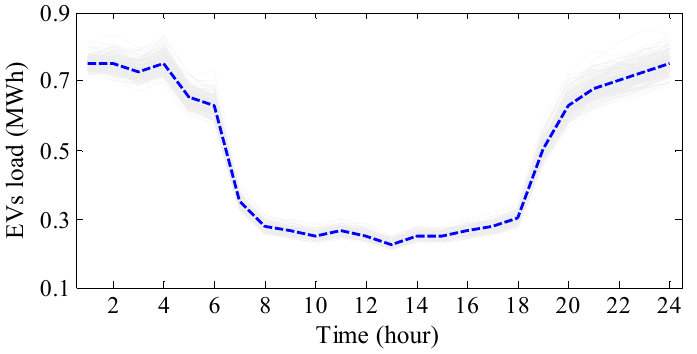
Figure 5. Scenarios and mean of negative imbalance price.